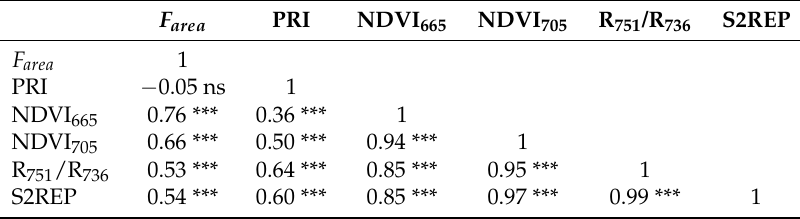
Table 2. Relationships between spectral transformations: in-filling of the O 2 -A Fraunhofer line around 760 nm ( F area ), Photochemical Reflectance Index (PRI), red NDVI (NDVI 665 ), red-edge NDVI (NDVI 705 ), new simple ratio at 736 nm and 751 nm (R 751 /R 736 ), and red-edge inflection point estimated by linear four-point interpolation approach (S2REP). Asterisks denote statistical significance of Spearman’s rank-order correlation coefficients.